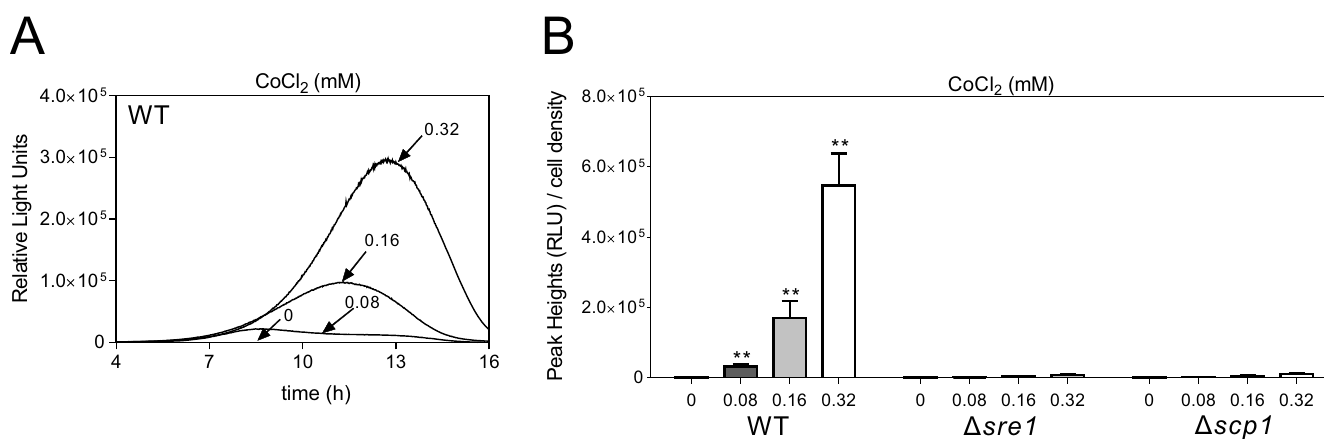
Fig 2. CoCl 2 activates Sre1-dependent SRE2 reporter activity. CoCl 2 (0.08 mM to 0.32 mM) induced a marked increase in Sre1 transcriptional activity. Wild-type cells harboring the multicopy reporter plasmid were cultured and assayed as described in Fig 1A–1C. (B) Two orders of magnitude reduced from wild type cells were observed in Δ sre1 and Δ scp1 cells. The Δ sre1 and Δ scp1 cells harboring the multicopy reporter plasmid were cultured and assayed as described in Fig 1A–1C. Y-axis values are the relative light units (RLU) of peak height normalized to cell density (OD660) of each sample at the peak time. The data were averaged from three independent experiments, and each sample was done in triplicate. Error bars indicate means (n = 3) ± S.D. �� P < 0.01 compared with the vehicle condition for the respective